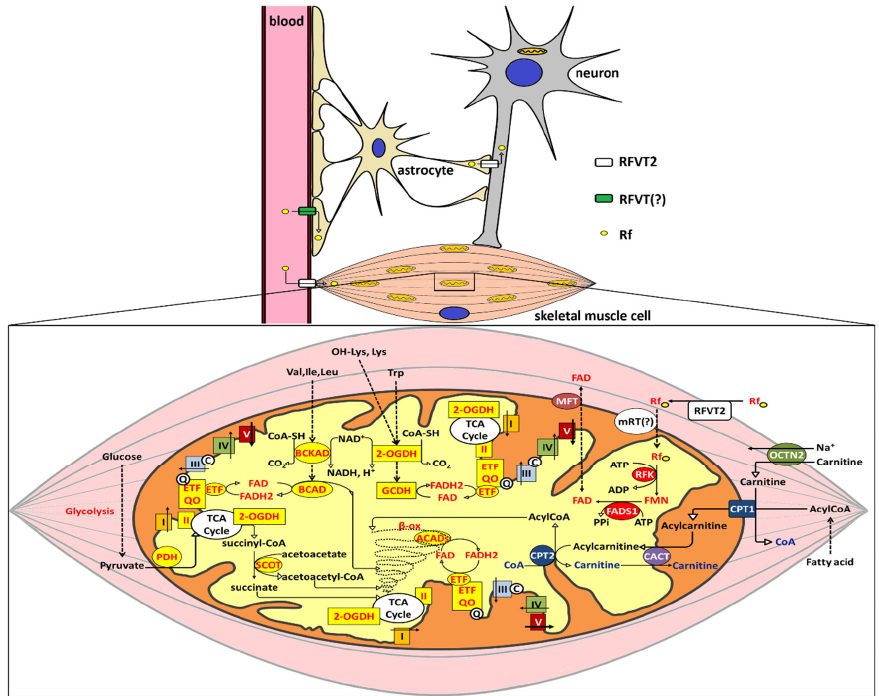
Figure 4. Rf transport and FAD mitochondrial delivery in skeletal muscle and neuronal cells, in relationships with flavin-dependent mitochondrial oxidative pathways. At the top of the figure, the Rf uptake from blood into target cells (neuronal and skeletal muscle cells) presumably involving RFVT2. At the bottom of the figure, a magnification of mitochondrial flavoprotein metabolism in muscle is depicted. Flavoproteins are depicted in yellow. Abbreviated names of transporters and enzymes are indicated in the figure as listed below: RK: Riboflavin kinase (EC 2.7.1.26); RFVT2: plasma membrane riboflavin transporter 2; FADS1: FAD synthase isoform 1 (EC 2.7.7.2); mRT: mitochondrial riboflavin transporter; MFT: mitochondrial folate transporter; CACT: mitochondrial carnitine acylcarnitine translocase; OCTN2: organic cation transporter novel 2; CPT1: carnitine palmitoyltransferase 1; CPT2: carnitine palmitoyltransferase 2; I: respiratory chain complex I (NADH-ubiquinone oxidoreductase); II: respiratory chain complex II (succinate dehydrogenase); III: respiratory chain complex III (ubiquinol-cytochrome c reductase); IV: respiratory chain complex IV (cytochrome c oxidase); V: respiratory chain complex V (ATP synthase); 2-OGDH: 2-oxoglutarate